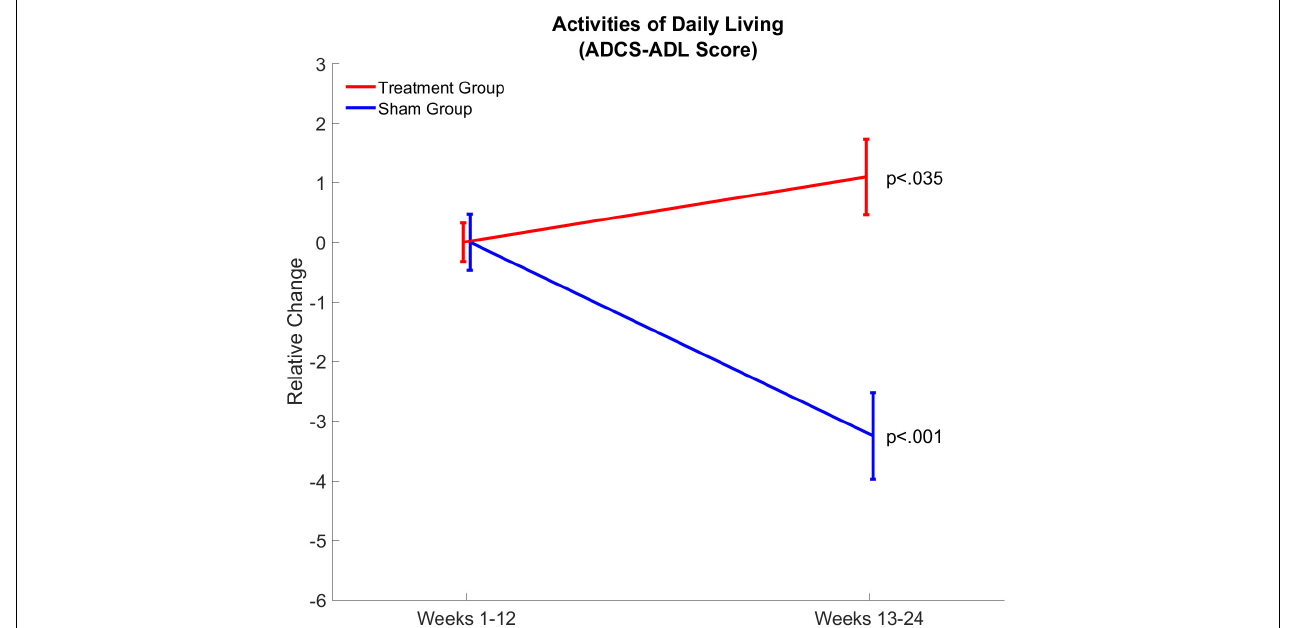
FIGURE 5 | Gamma sensory stimulation therapy results in maintenance of daytime activities assessed by Activities of Daily Living (ADCS-ADL) Score. Relative changes in daytime activities are shown between weeks 1–12 and weeks 13–24 in the treatment (red; n = 14) and sham (blue; n = 8) groups. Changes in daytime activities showed a significant ( p < 0.035) improvement in the treatment group and a significant ( p < 0.001) decline in the sham